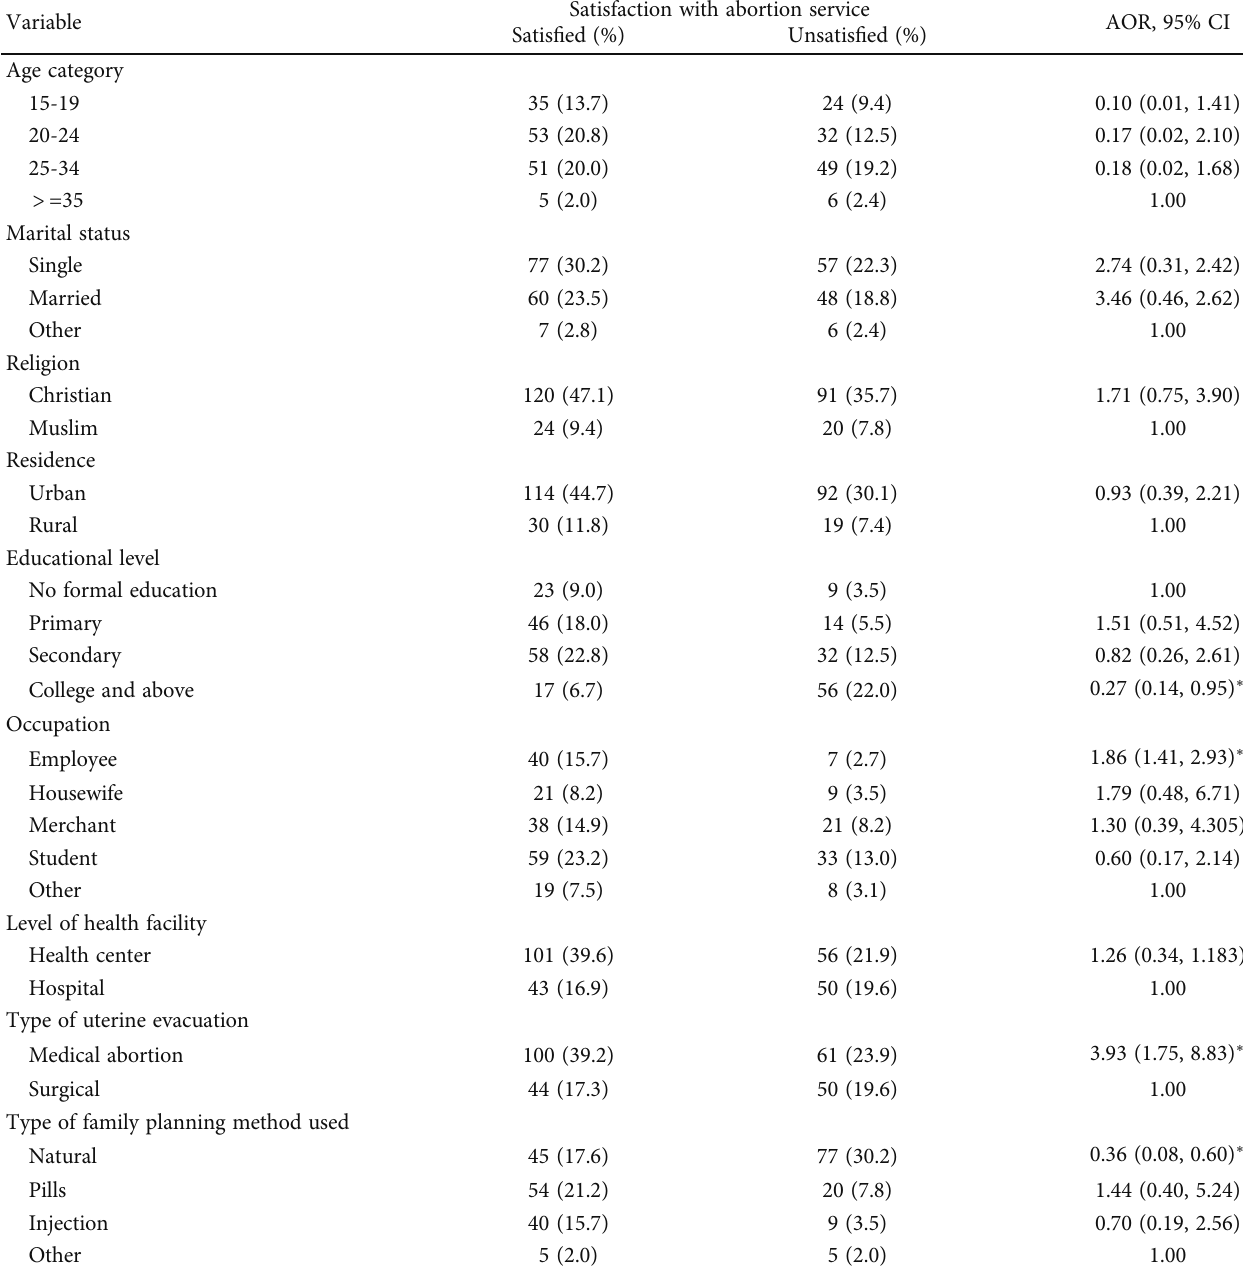
Table 4: Result of bivariable and multivariable analysis on the association between the study variables among respondents in Mojo town.